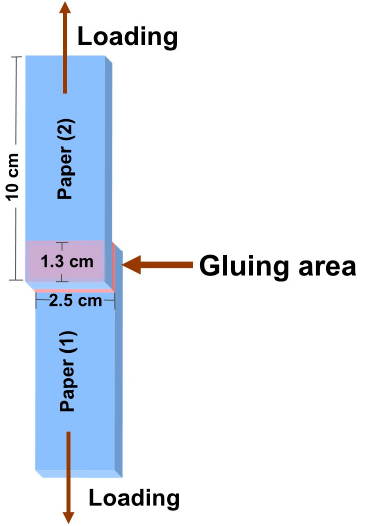
Figure 1. Schematic of shear strength on the paper substrate.